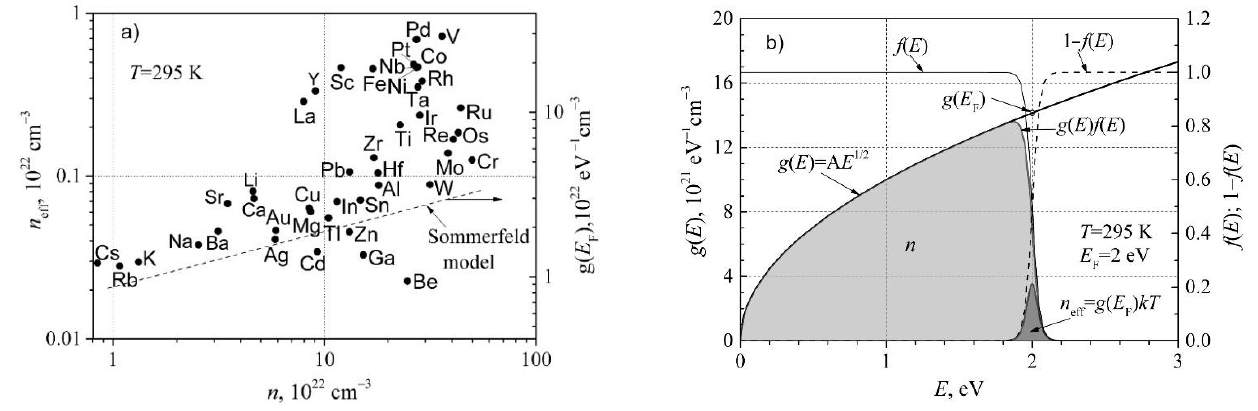
Figure 2. ( a ) The DOS at the Fermi level energy g ( E F ) (right scale) and the effective density of the RM electrons n eff (left scale at T = 295 K, calculated by Equation (3)) distribution on the total density of the valence electrons in the conduction band for elemental metals. The dash line (right scale) is under Sommerfeld′s model. The data g ( E F ) are calculated by Equation (7) by using the electronic heat capacity values [15,16]. ( b ) Illustration of the DOS g ( E ) and g ( E ) f ( E ) functions (left scale) on the energy of the electrons in the conduction band with parabolical energy band. The light grey area represents the total density n of the valence electrons (calculated by Equation (1)), and the dark grey area represents the effective density n eff of the RM electrons (calculated by Equation (3)). There are also presented the Fermi functions f ( E ) and [1 − f ( E )] (right scale). Figure 2a with permission of the Nova Science Publishers .